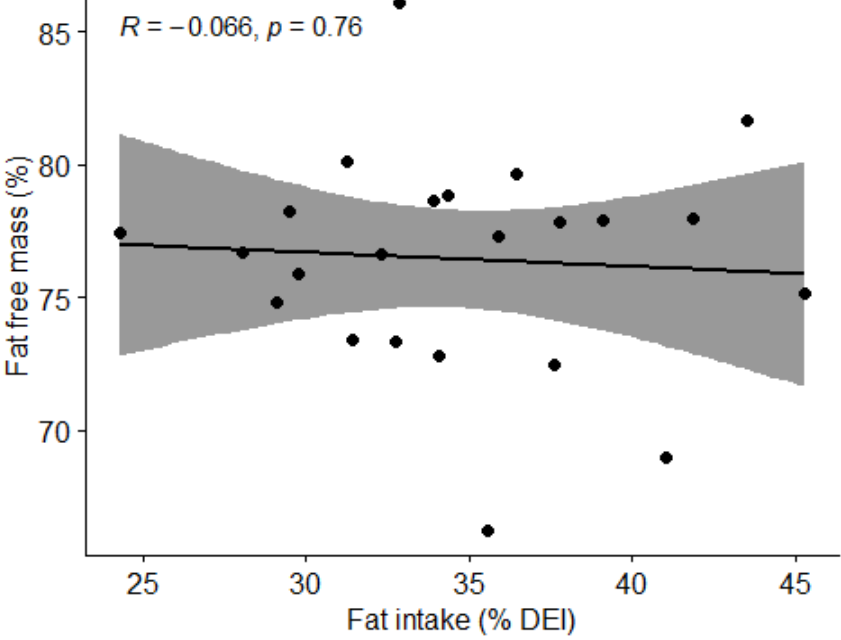
Figure 13. Correlation between percentage of fat and percentage of lean body mass in football players. Dots represent individual participants ( n = 23). Grey shaded area indicates 95% CI.